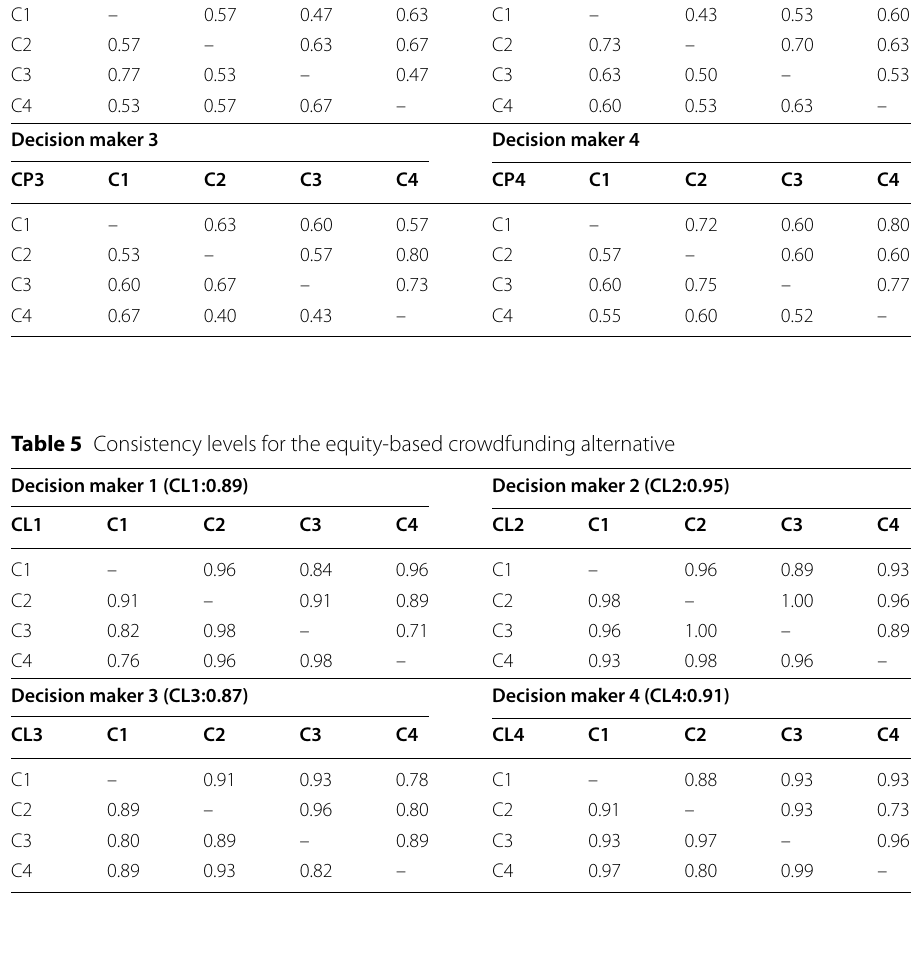
Table 4 Corresponding fuzzy preference relations for the equity-based crowdfunding alternative Decision maker 1